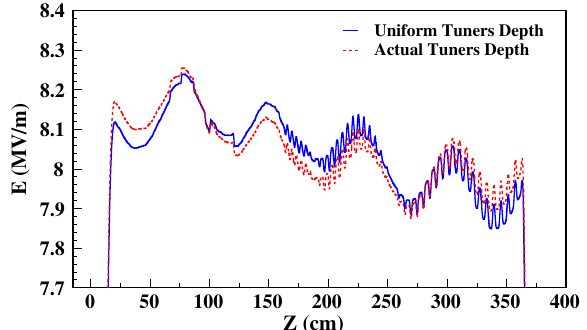
FIG. 21. Peak surface electric fields calculated in MW-Studio for both the sinusoidal (top) and trapezoidal (bottom) RFQ